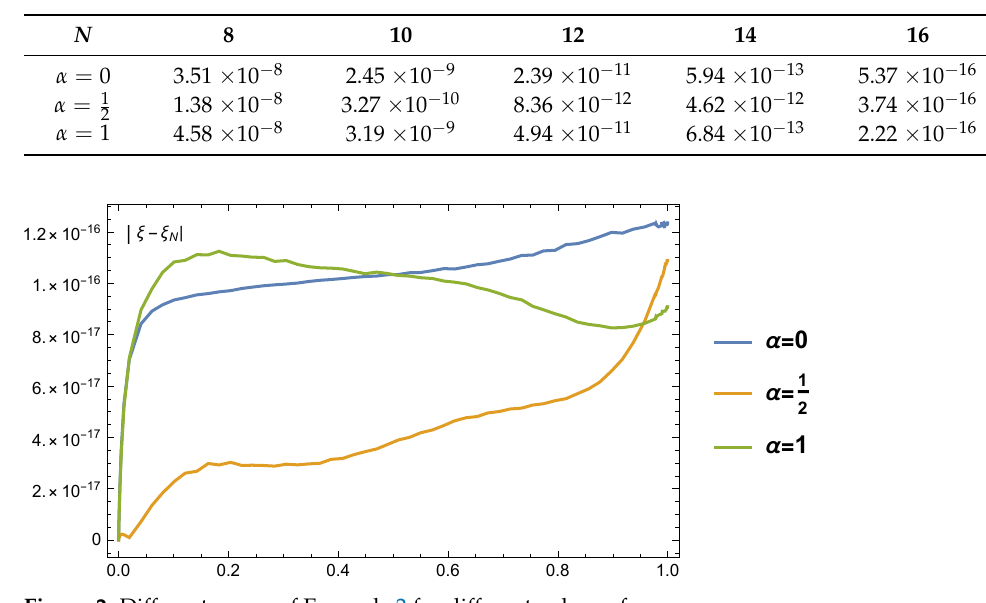
Table 3. Maximum absolute error for Example 2.